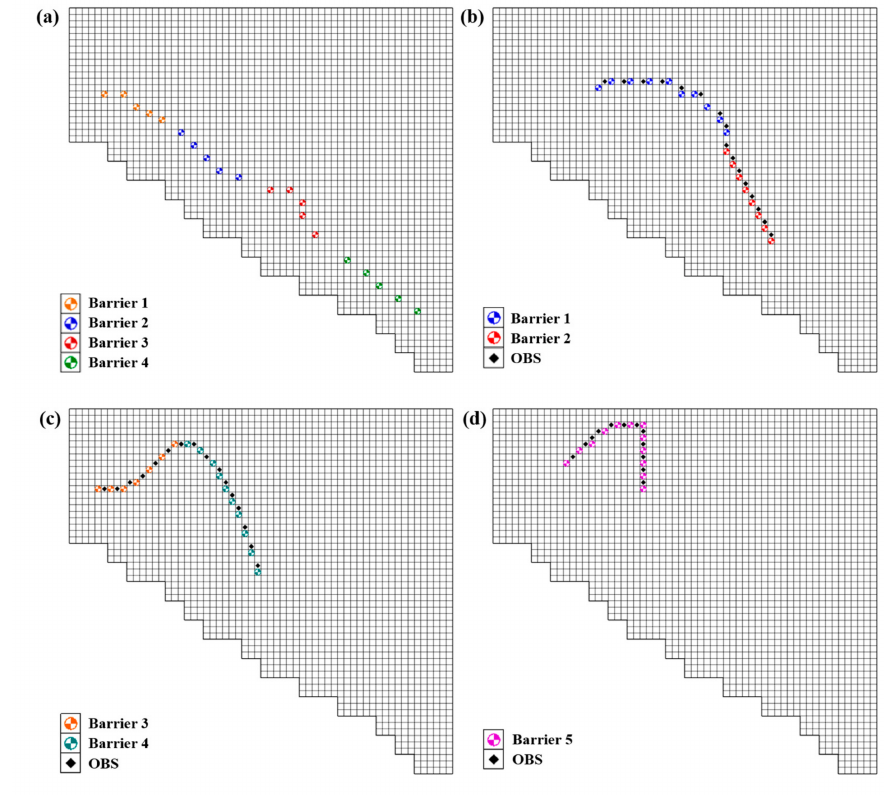
Figure 8. The deployment of injection barriers for two management scenarios: ( a ) Scenario #1; ( b ) aquifer F1 in Scenario #2; ( c ) aquifer F2 in Scenario #2; ( d ) aquifer F3-1 in Scenario